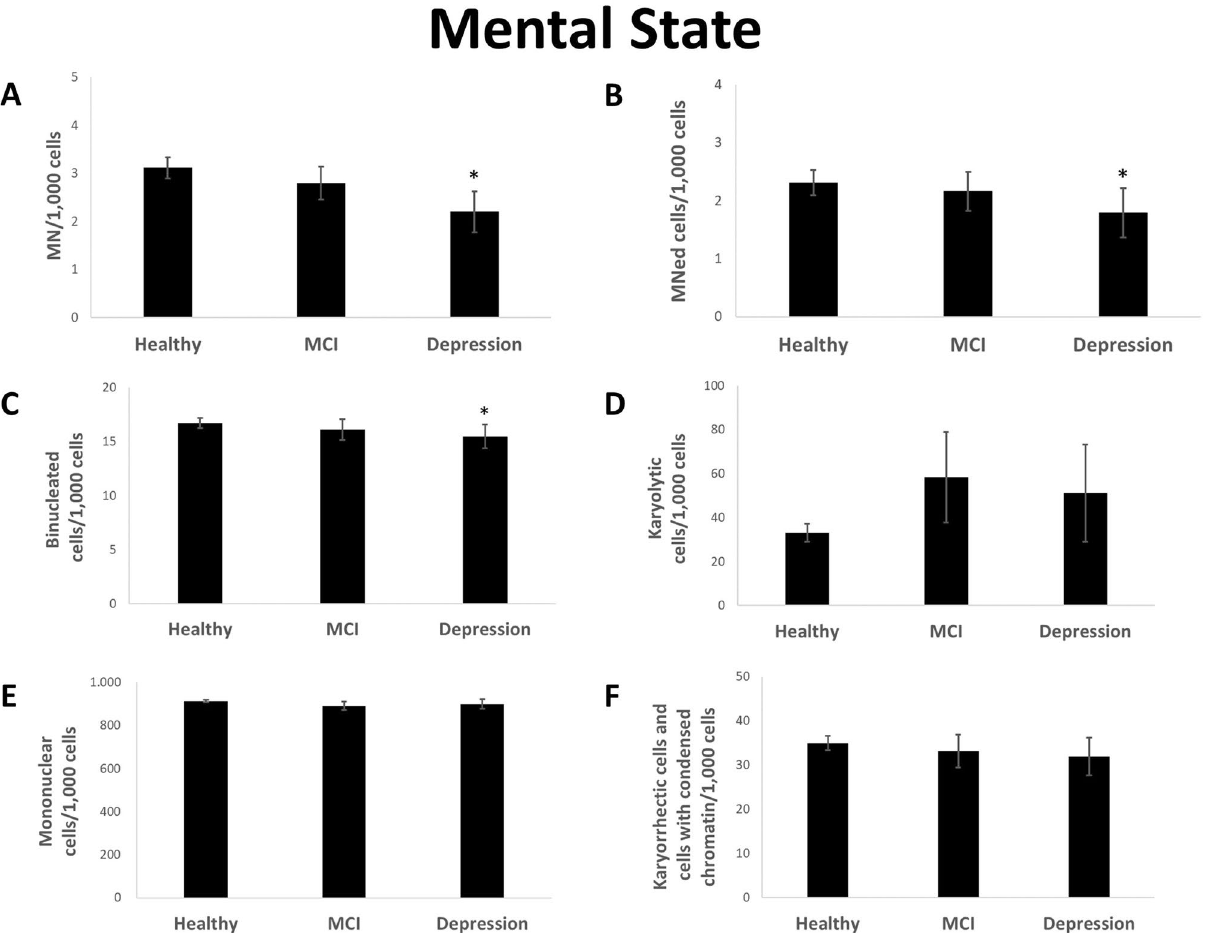
Figure 5. Rate of MN ( A ), MNed cells ( B ), binucleated cells ( C ), karyolytic ( D ), mononuclear ( E ) and karyorrhectic cells and cells with condensed chromatin ( F ) per 1000 cells from reference distributed by mental state. Mean of each group ± standard error. n (healthy): 249; n (MCI): 43; n (depression): 32. Asterisk represent p value < 0.05 after statistical evaluation referring to